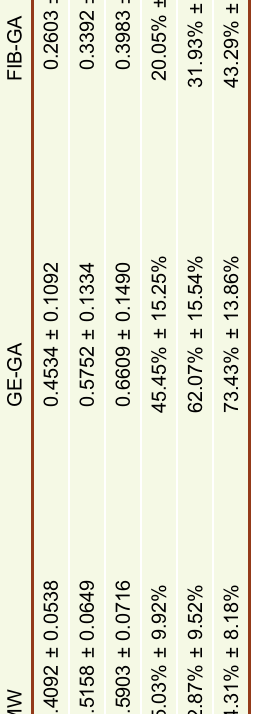
Figure 3. The FT performance of ANNs in solving an XOR problem with multiple faulty parameters or neurons in the hidden layer. (A) The histogram of error occurrence in 20 independent experiments using ANNs trained via BP, MW, GE- GA, and FIB-GA methods. (B and C) The plot of errors versus faulty neurons (B) and a histogram of error occurrence (C) in 20 independent experiments using ANNs trained via BP, MW, GE- GA, and FIB-GA